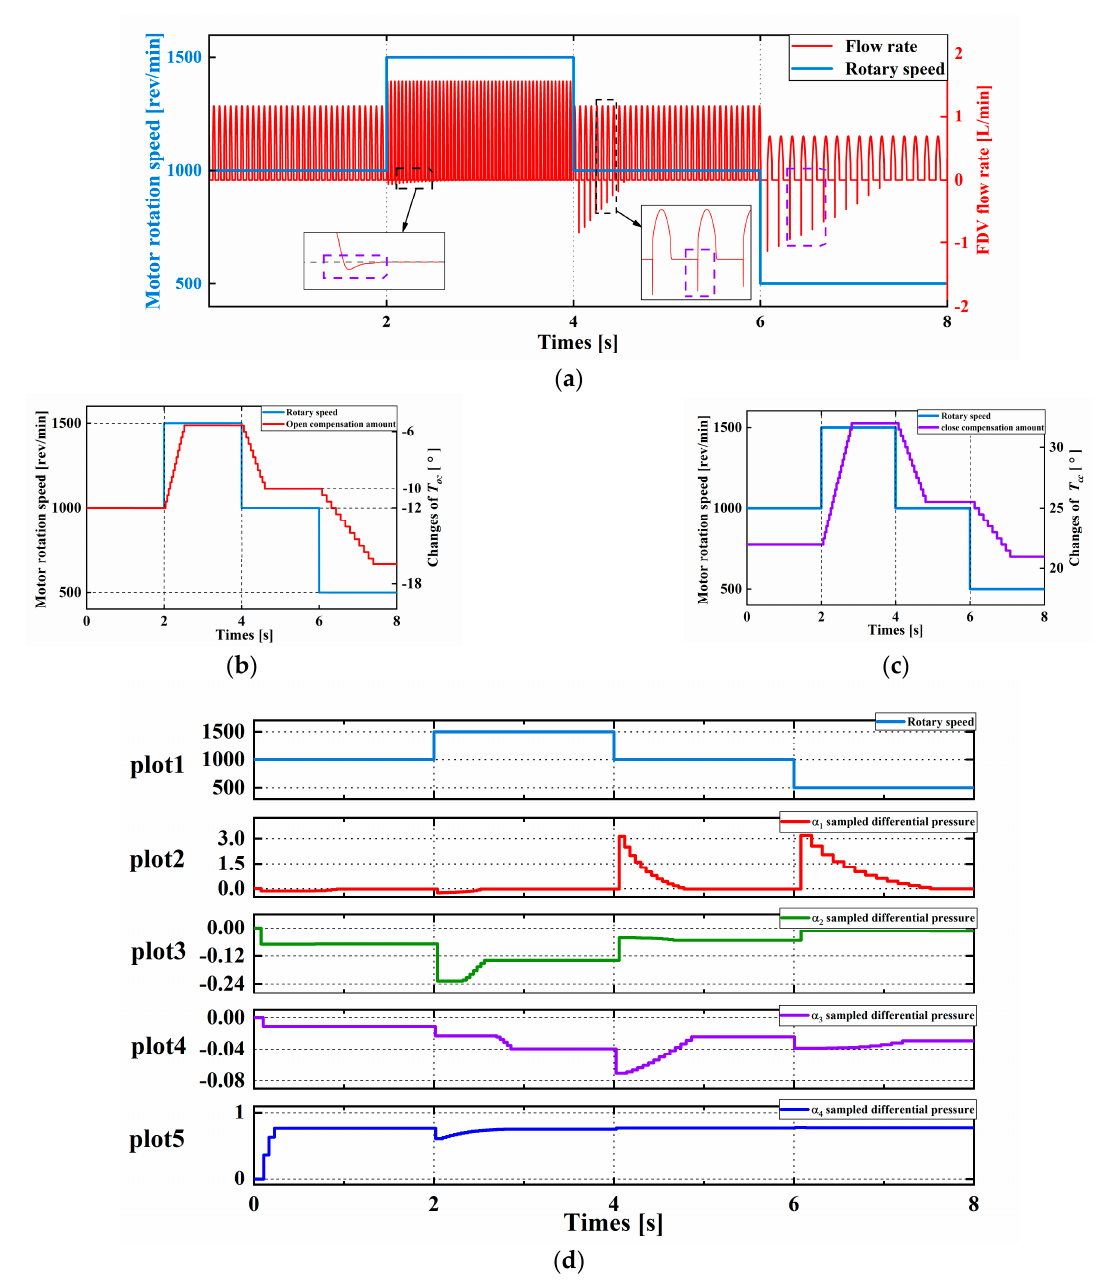
Figure 10. The results with different motor speeds: ( a ) flow rate of FDV; ( b ) T oc curve; ( c ) T cc curve; ( d ) plot 1: Motor speed; plot 2–4: differential pressure at α 1 , α 2 , α 3 , α 4